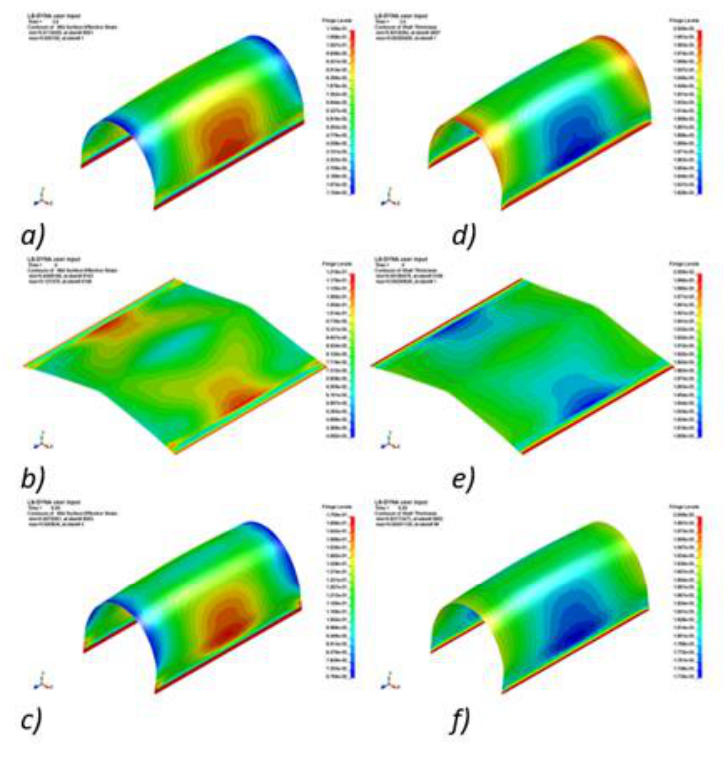
Figure 7. Distributions of the experimental data 14 from the third kinematic scheme in the following stages: after the first skinning by an angle of 900 (a, d), after the part is bent through the angle 120 and its stretching (b, e), at the end of the molding operation (c, f); a, b, c - distribution of effective deformations along the middle shell surface; d, e, f is the shell thickness